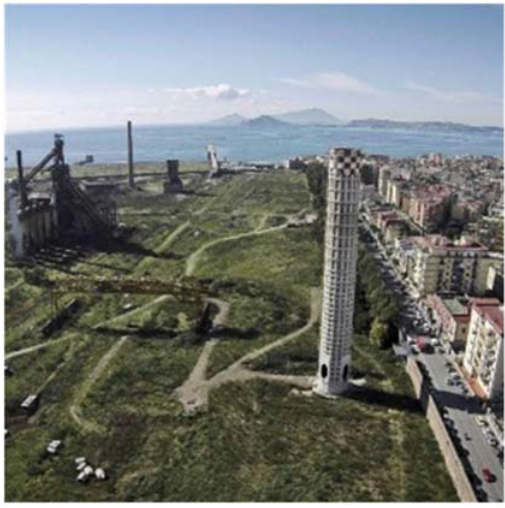
Figure 4 . View of the urban void left by the decommissioning of steel plants. Figure 4. View of the urban void left by the decommissioning of steel